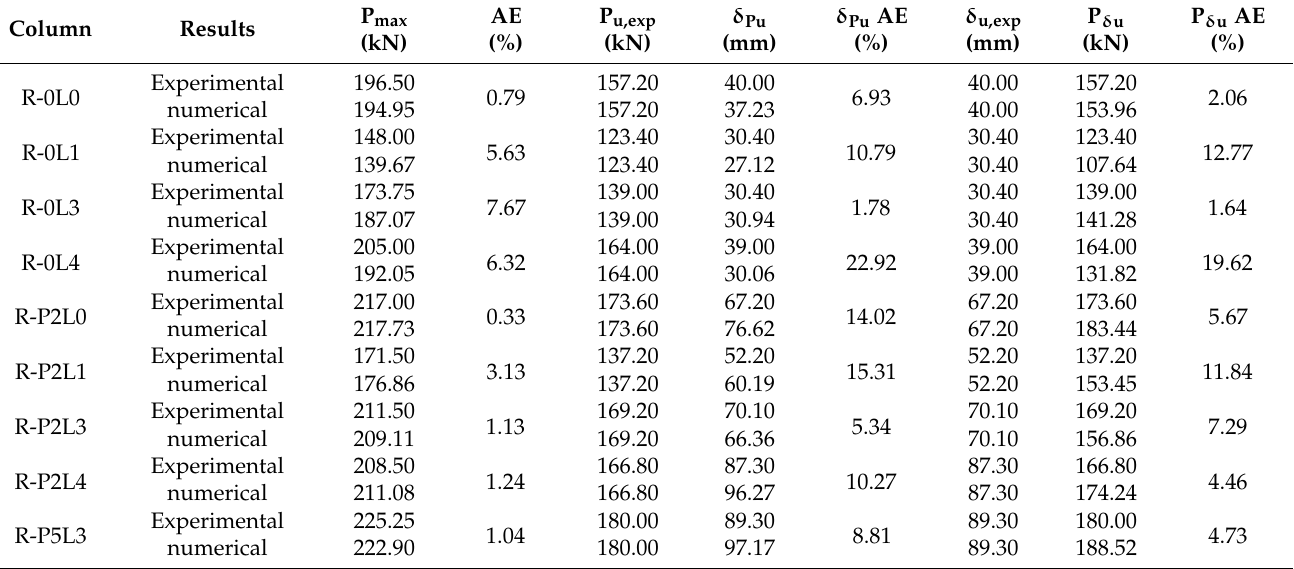
Table 5. Comparative experimental and numerical results of columns R-0L0, R-0L1, R-0L3,